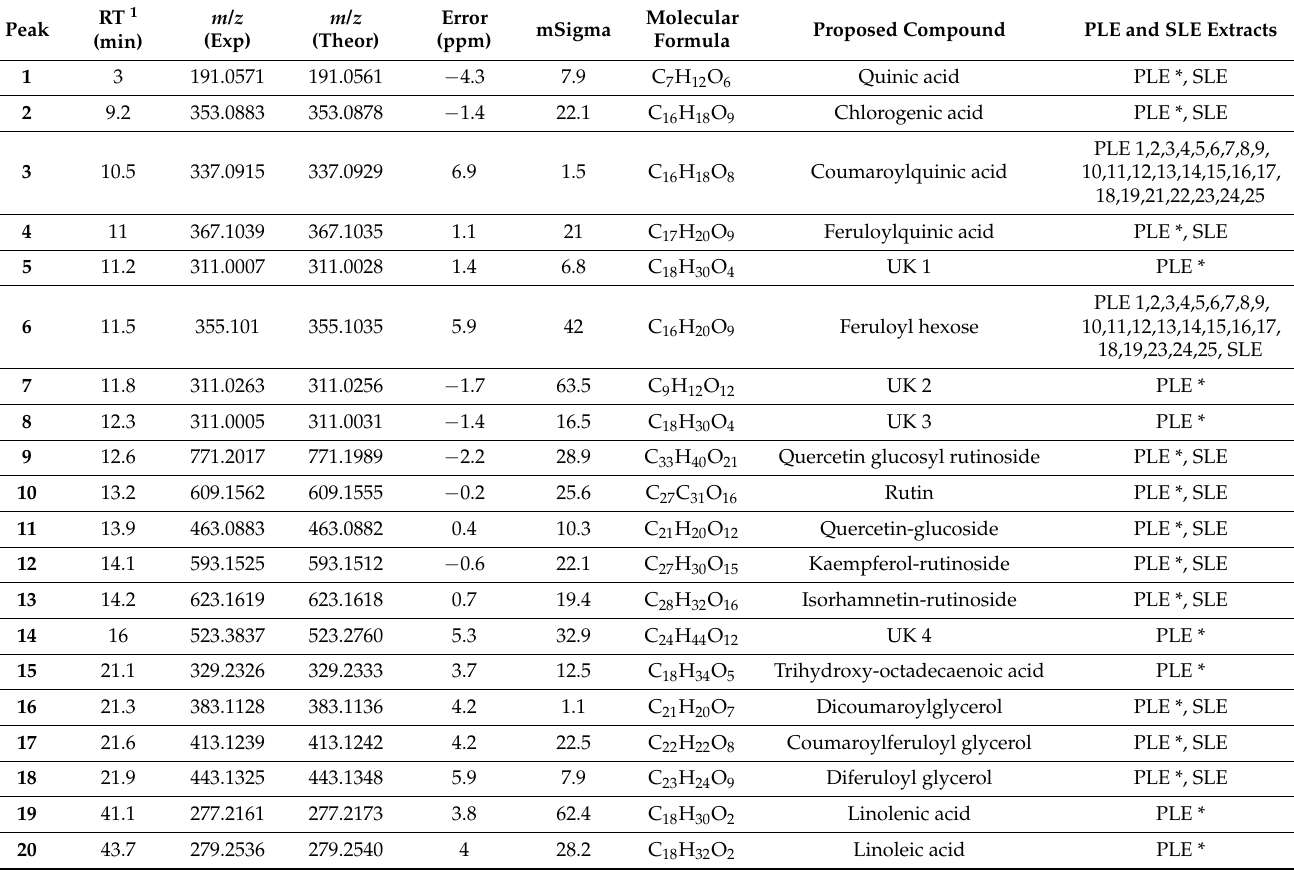
Table 1. Tentatively identified compounds in the analyzed asparagus